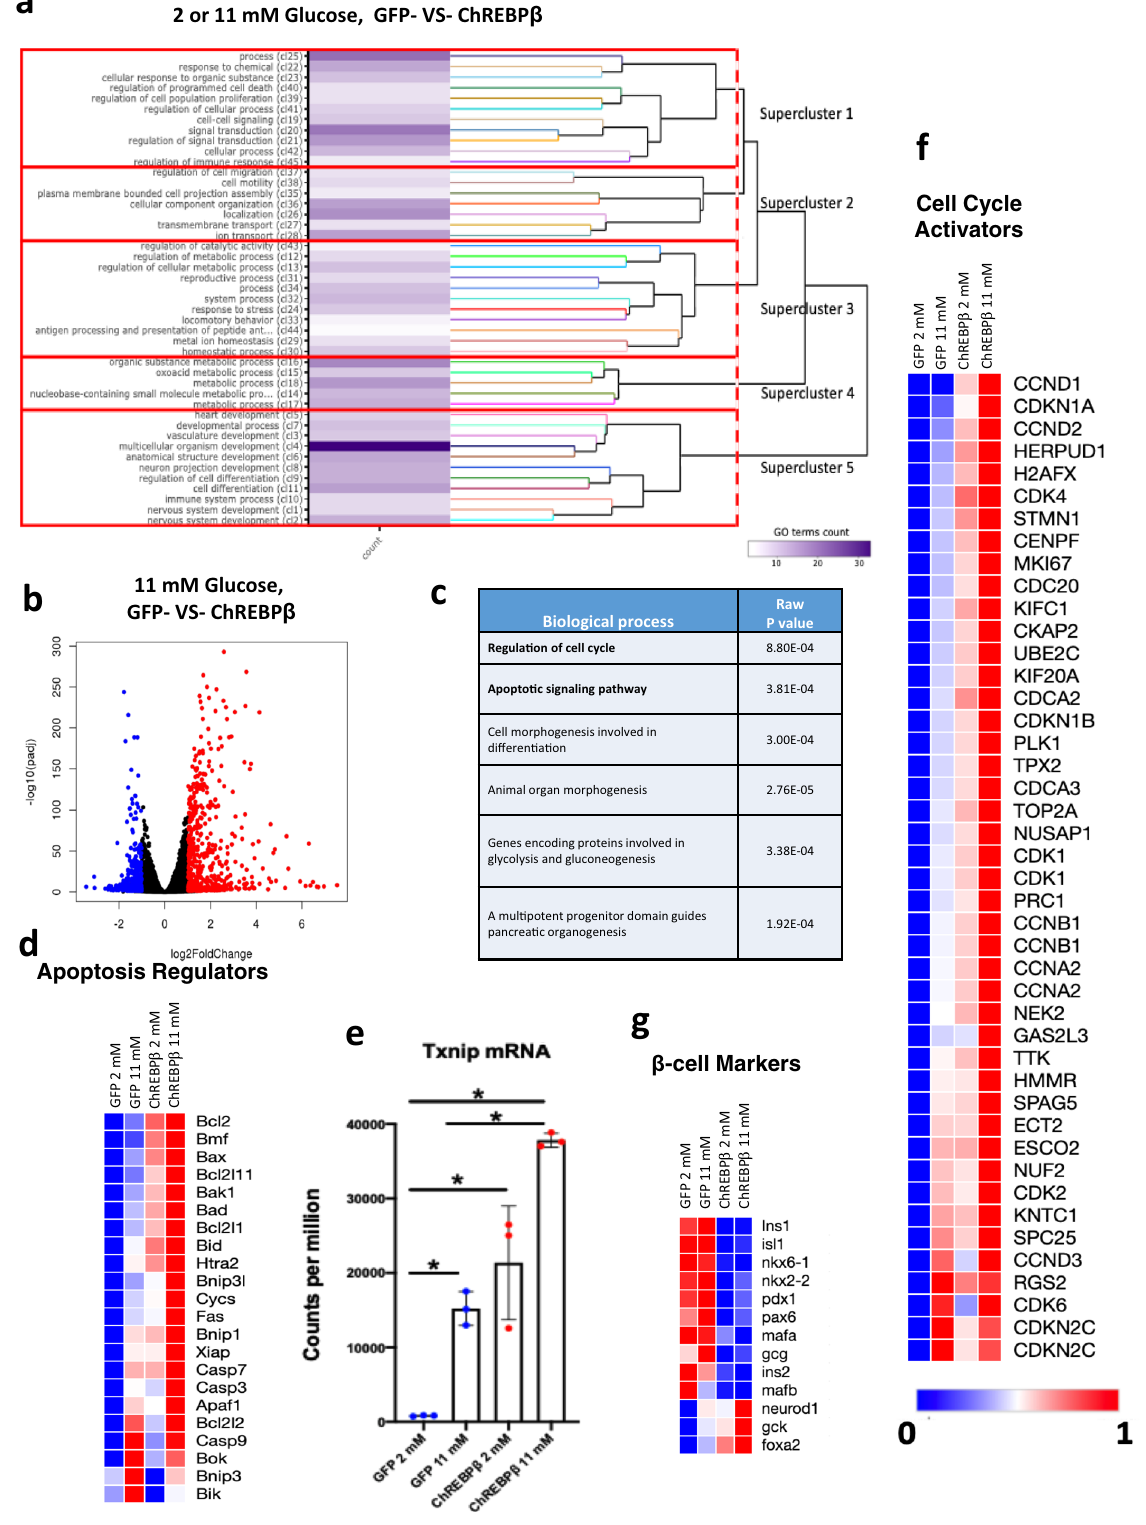
Fig.7|ChREBP β initiatesprogramsofcellcycleregulationandapoptosiswhen overexpressed in Ins-1 cells. Ins-1 cells were transduced with an adenovirus expressing GFP or ChREBP β and cultured for 48h in 2 or 11mM glucose. RNA was collected and RNA-seqwas performed. a Heatmap ofthe cluster of GO terms. The 471 GO terms (pathways) enriched by differentially expressed genes across the 6 DGEs from the 4 groups (see text) are grouped into 45 clusters of GO terms. The hierarchical tree scoring the distances between each of the 45 clusters originates superclusters that are boxed in red. The superclusters highlight the main cellular